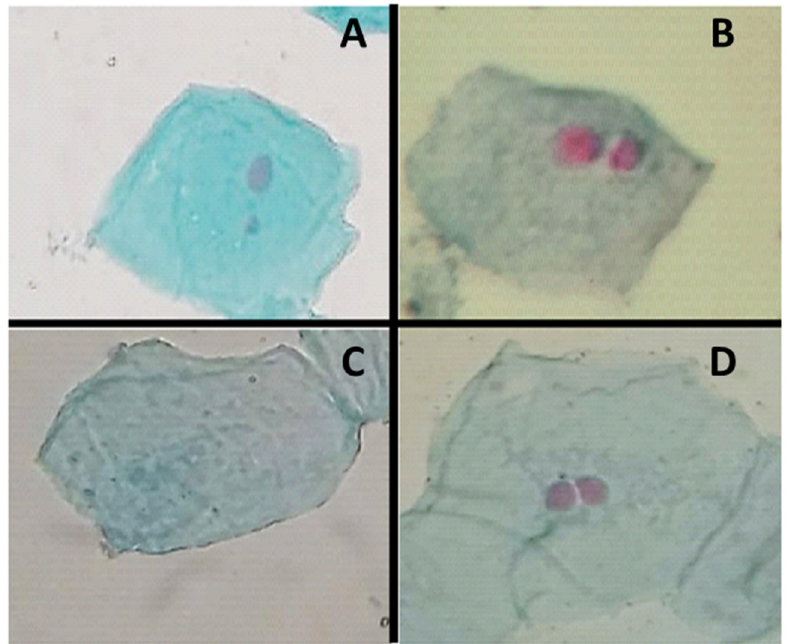
Figure 2. Alterations observed in exposed individuals and controls. ( A ): Micronucleus cell (MN); ( B ): Binucleated cell (BN); ( C ): Karyolitic cell (KL); ( D ): Binucleated cell (BN).